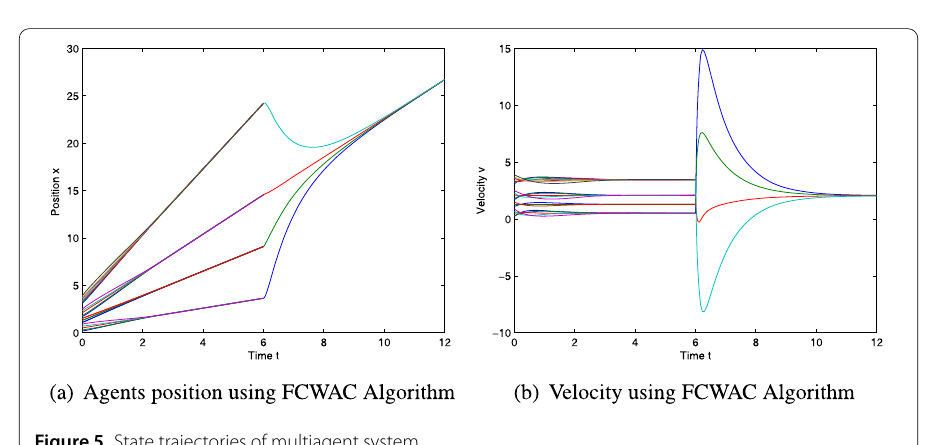
Figure 5 State trajectories of multiagent system